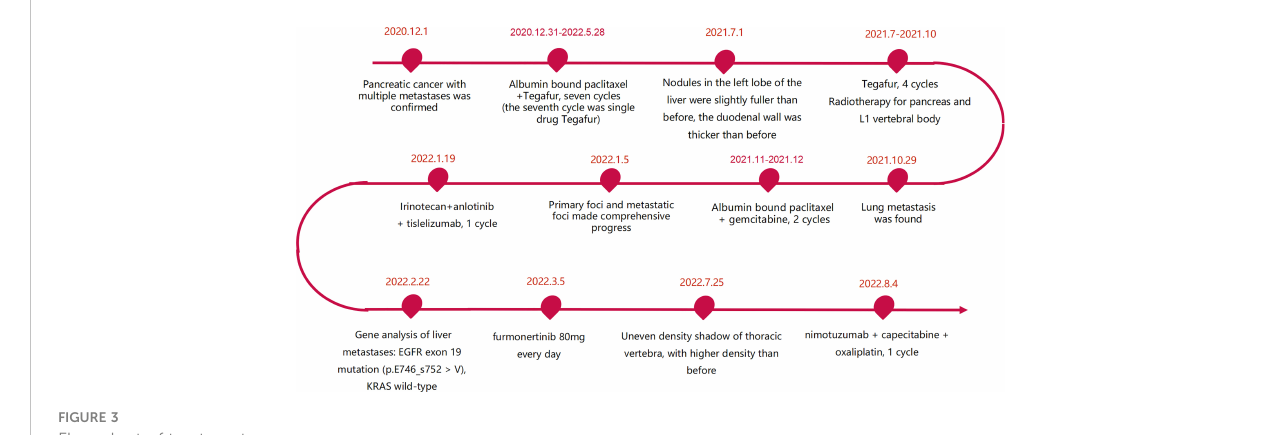
FIGURE 3 Flow chart of